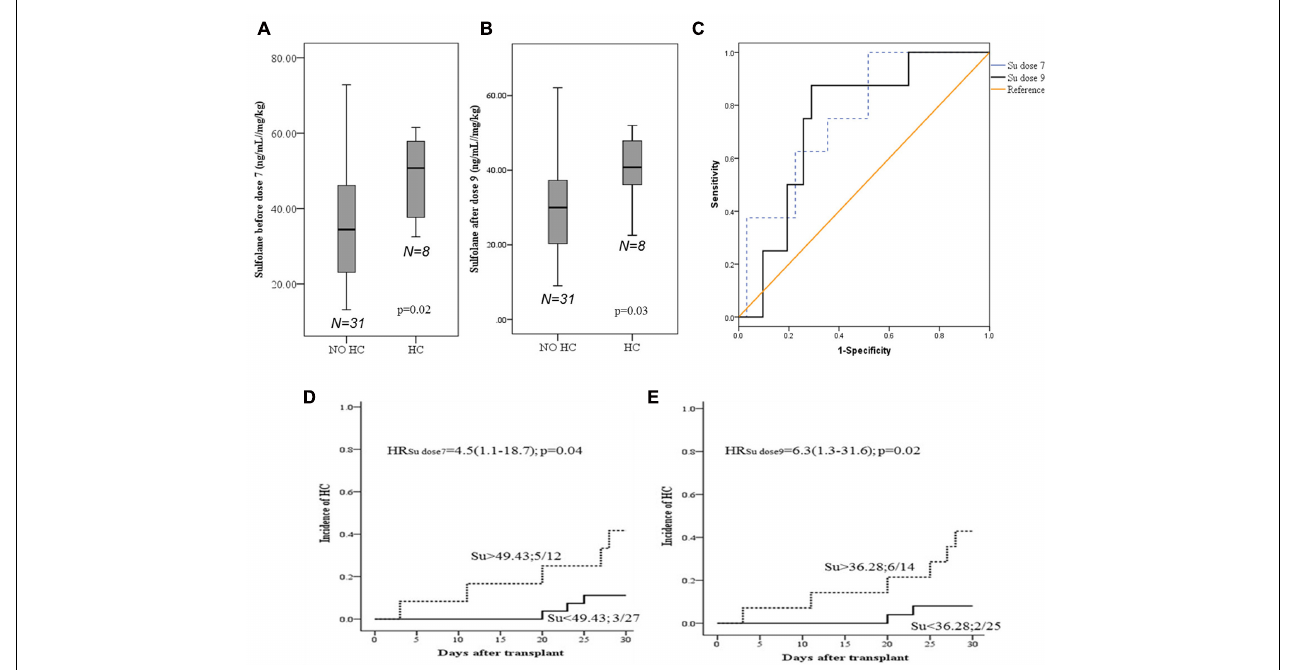
FIGURE 2 | Sufolane levels and occurrence of Hemorrhagic cystitis. (A,B) Su levels between patients with and without HC. (C) ROC curve for Su levels as a predictive marker for HC ( n = 39). A cut off of 49.43 and 36.28 ng/mL/mg/kg for HC, before dose 7 and after dose 9, respectively [before dose 7; Area = 0.75 (95% CI: 0.59–0.93; p = 0.02); after dose 9; Area = 0.74 (95% CI: 0.57–0.91), p = 0.03]. (D,E) Cumulative incidences HC. Patients with HC/total number of patients in each group. (D) Before dose 7 (E) after dose 9.